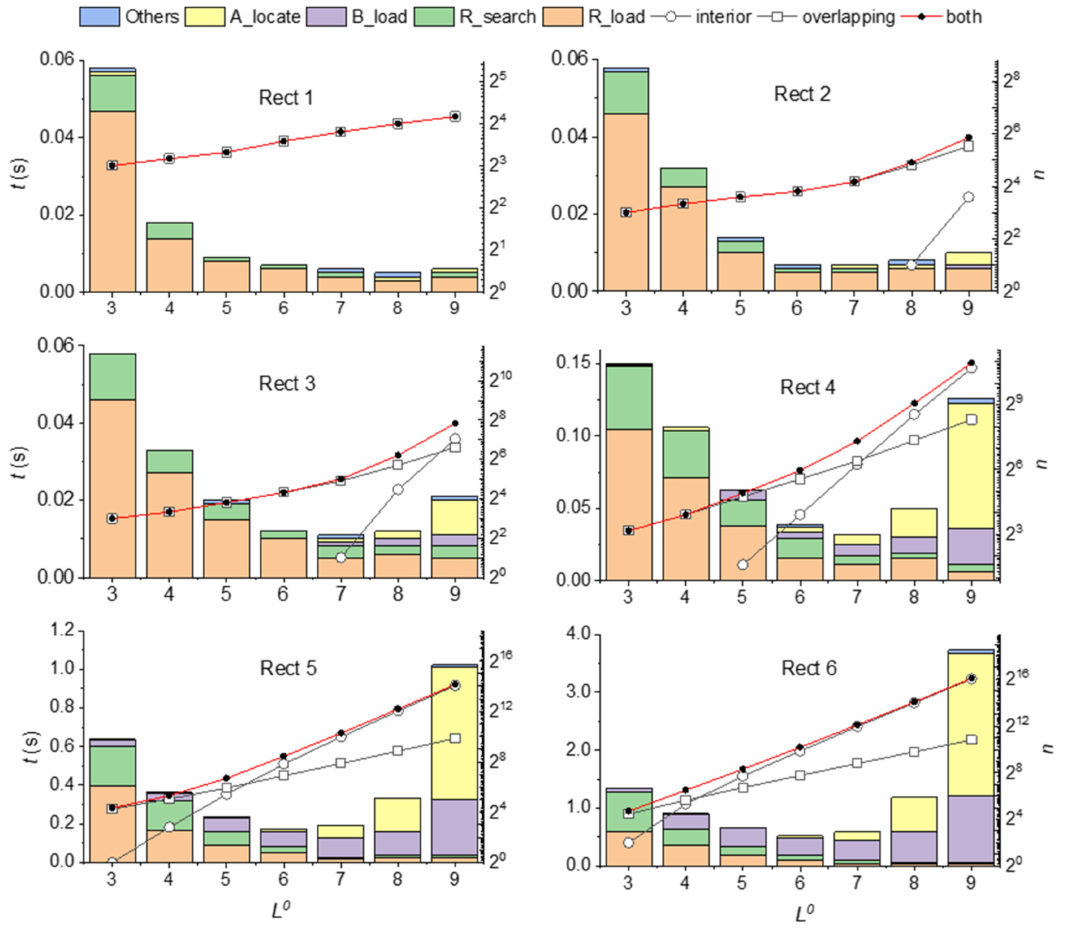
Figure 7. Time cost ( t ) of each step in a region query using different rectangles against L 0 for the QRB-tree index and total number ( n ) of grids covered by each rectangle. ‘R_load’, ‘B_load’, ‘A_locate’, and ‘Others’ refer to the R-tree loading step, bucket loading step, auxiliary file locating step, and remaining steps of a region query, respectively. The subplots from left to right and top to bottom correspond to the query by the six rectangles shown in Figure 6a, in